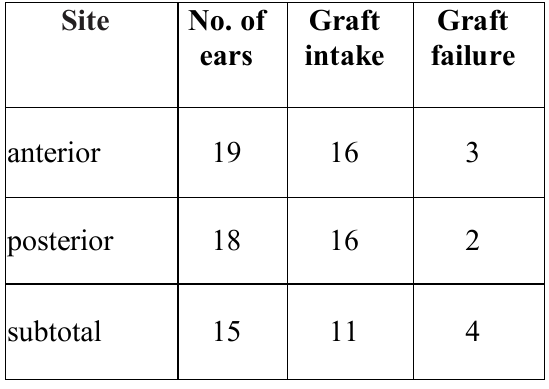
Table 6(b): Audiological results in